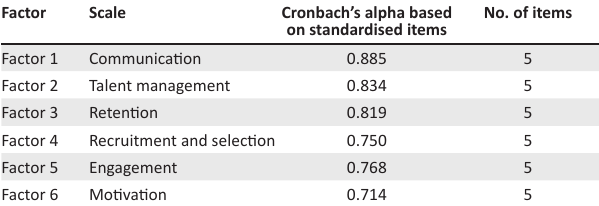
TABLE 2: Cronbach’s alpha for six factors affecting performance management at Statistics South Africa.